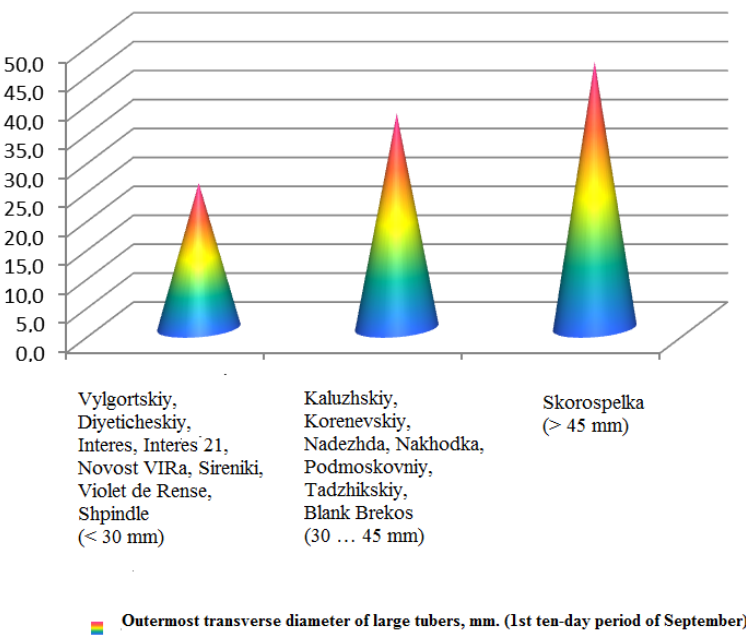
Figure 5. Outermost transverse diameter of large tubers, mm (1st ten-day period of September). The content of dry matter, total sugars, and inulin in tubers of the studied Jerusalem artichoke varieties was analyzed (Figure 6).